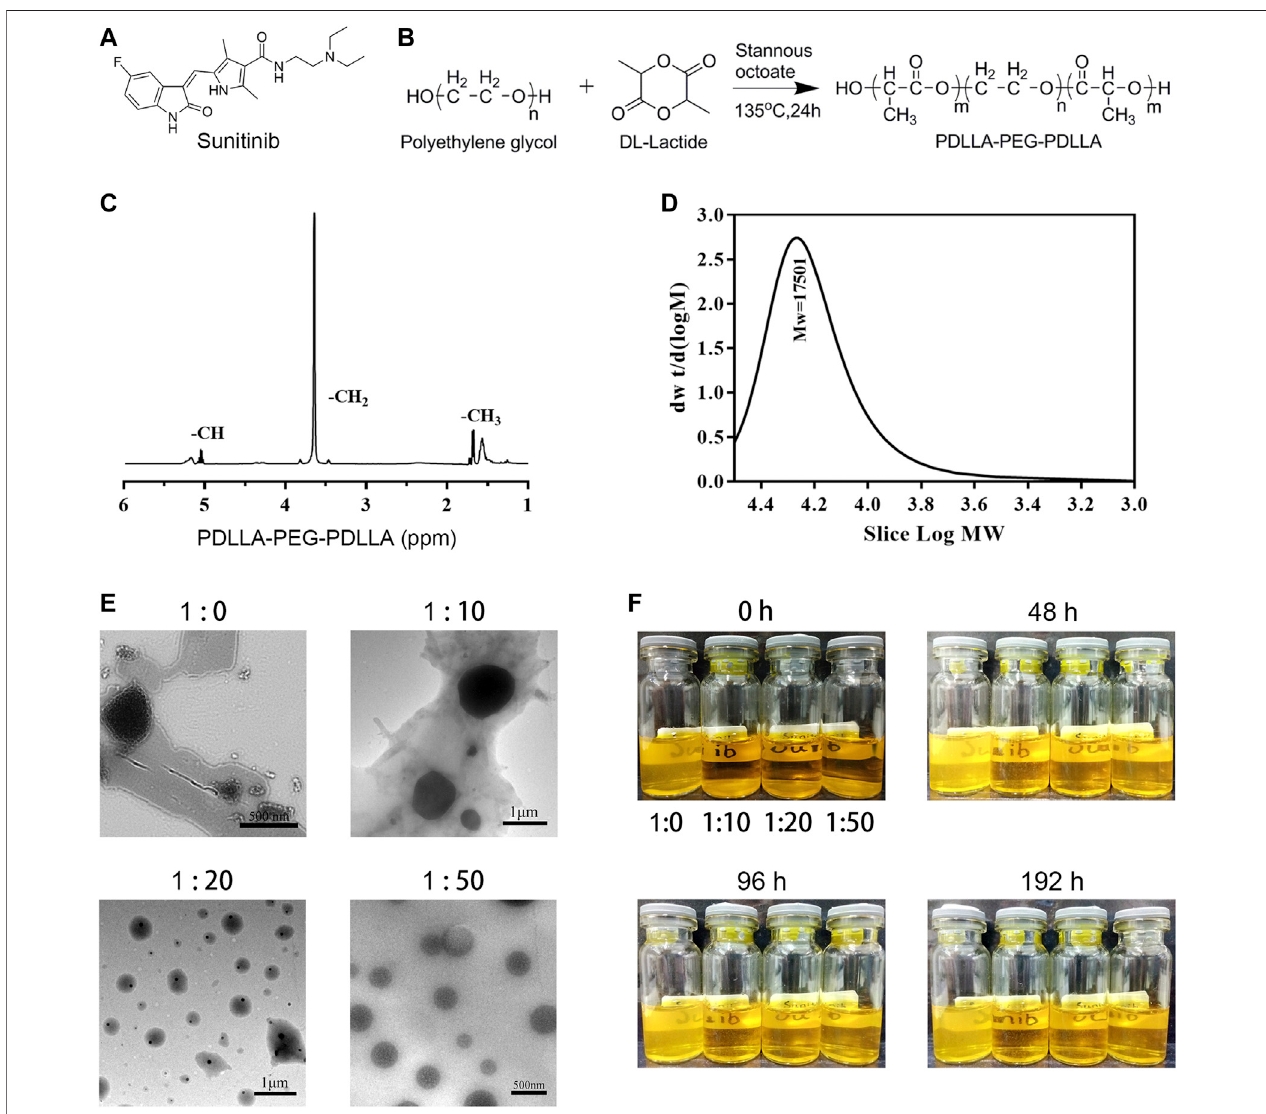
FIGURE 1 | Preparation and characterization of sunitinib nanoparticles. (A) Chemical structure of sunitinib. (B) The synthesis process of PPP. (C) HNMR of PPP. (D) Gel permeation chromatography (GPC) of PPP. (E) Representative SEM image of the nano-su. (F) Photograph of nano-su mixture solution at room temperature.